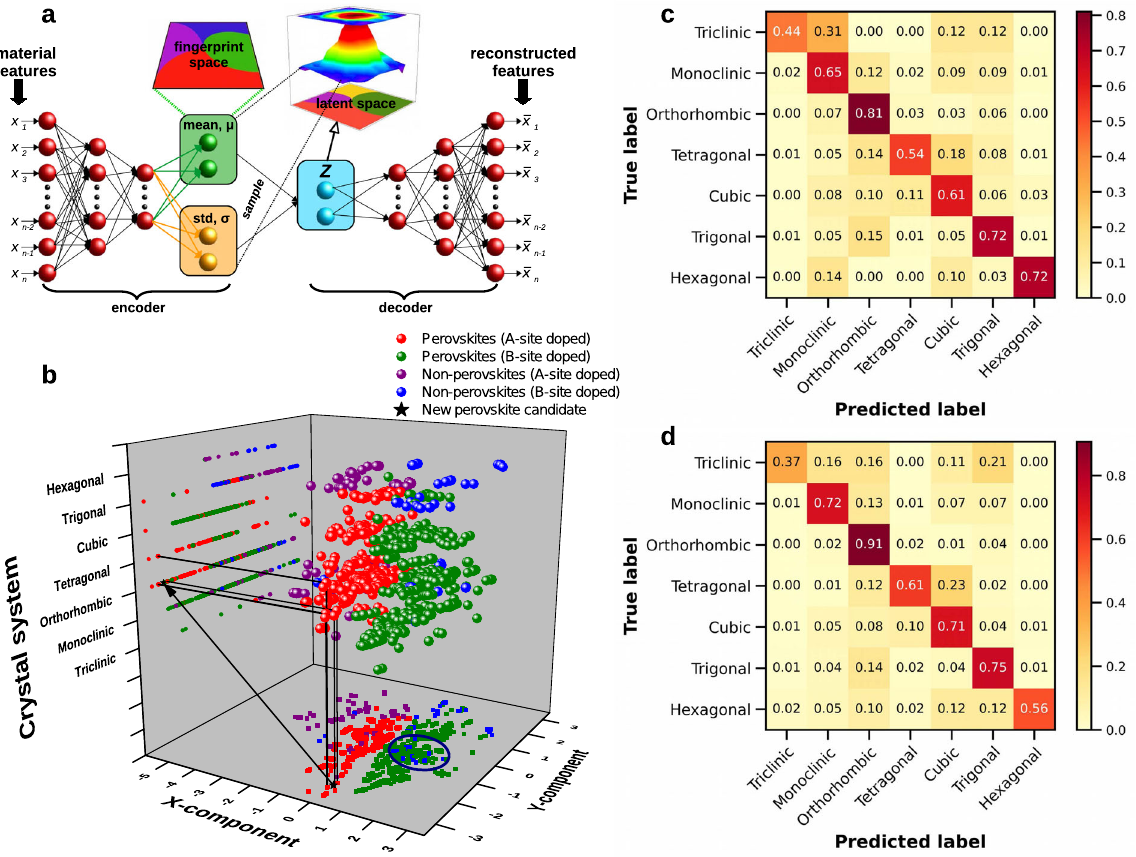
Fig. 4 Unsupervised material fi gerprinting using VAE. a VAE architecture. Encoder must fi nd an ef fi cient compression, discarding bulk of irrelevant information from the input to support the decoder to reconstruct the input itself from a highly compressed dimension. Because latent vector is sampled from a probability distribution, during the training process, the decoder learns not only a single point in latent space is relevant to a particular material, but also the nearby points. This removes blind spots to the decoder and enables placing unseen compositions on the fi ngerprint map. b Crystal system vs 2D fi ngerprint visualization of the experimental materials. XY plane relates to the fi ngerprint space. 14 non-perovskite labelled materials out of 20 landing inside the circled area were identi fi ed as ‘ perovskite ’ or ‘ hexagonal perovskite ’ in separate literature, which may not have been examined during data labelling. The crystal system of the indicated candidate is predicted to be orthorhombic based on the plurality vote of 5-NNs. c and d display the normalized confusion matrices detailing the crystal system prediction of 2104 experimental materials as obtained by proximity analysis of fi ngerprints and supervised gradient boosting classi fi er,